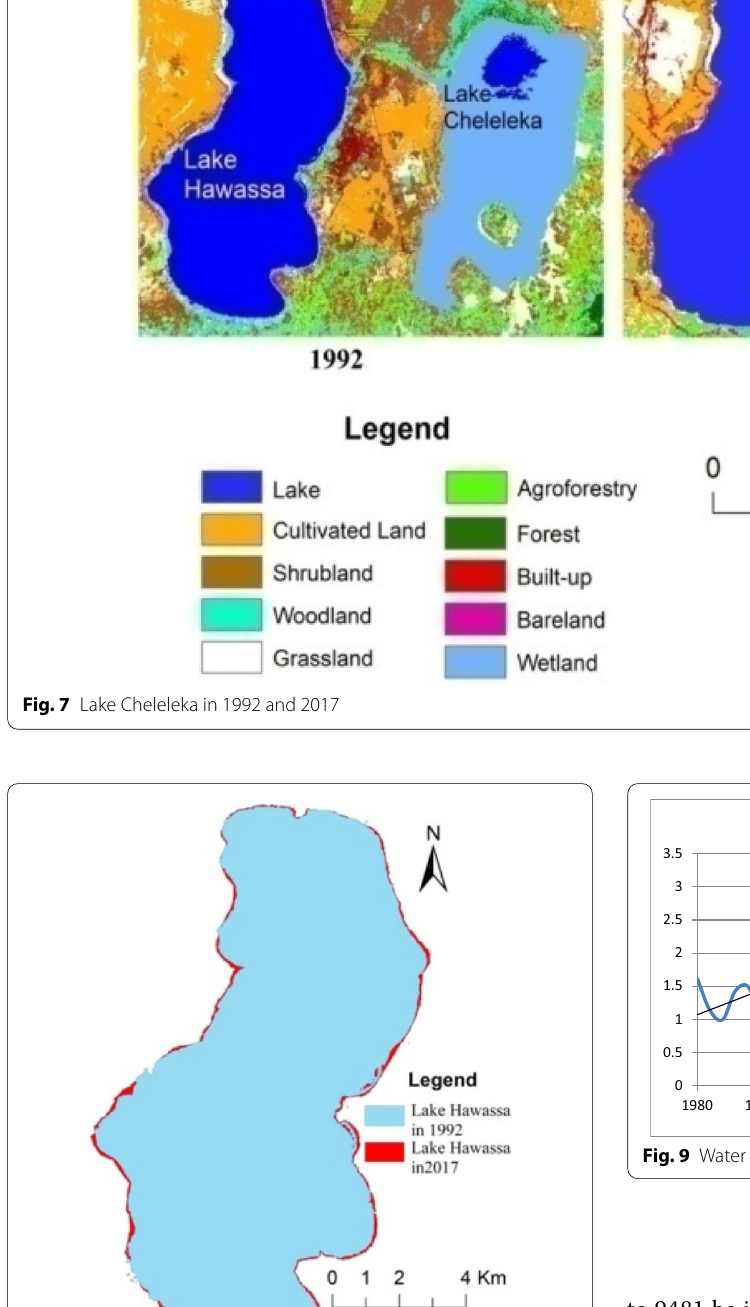
to 9481 ha in 2017, signifying the accumulation of sedi- ment in the lake and flow-out of the water to the sur- rounding areas (Fig. 8). A personal experience of the area indicates that the rise in the lake level and the resulting flooding have been the major environmental concerns threatening the nearby Hawassa city in the last few decades.